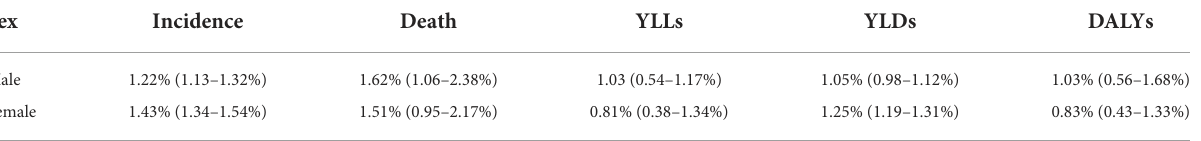
TABLE 5 Annual rate of change of gender-specific disease burden of IHD in China from 1990 to